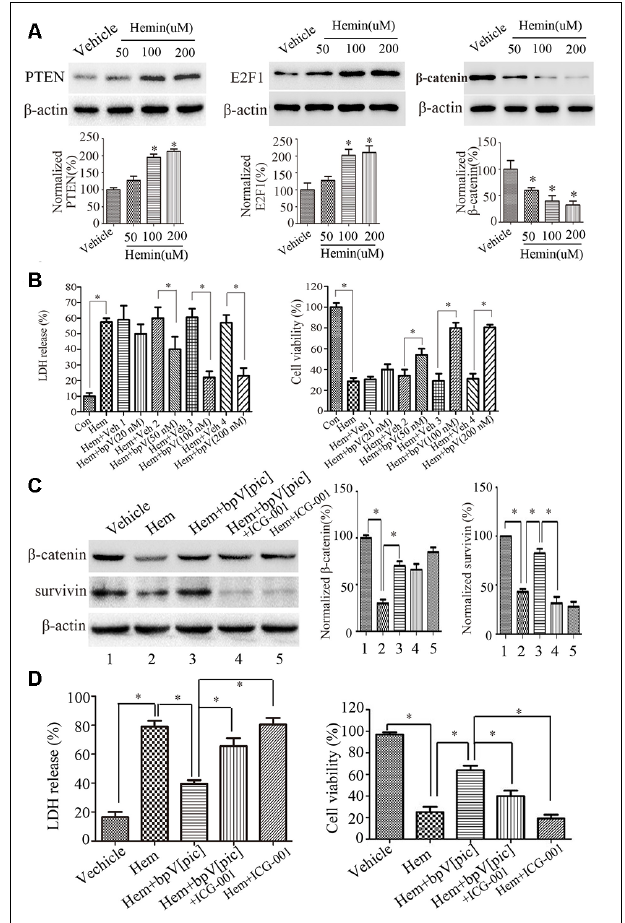
FIGURE 6 | BpV[pic] prevented hemin-induced neuronal damage through the regulation of β -catenin expression and activity via PTEN/E2F1 pathway in vitro . (A) Western blot showed it increased the expression of PTEN and E2F1, decreased the expression of β -catenin concentration-dependently in hemin-treated cultured rat cortical neurons for 24 h ( ∗ p < 0.05 compared to Vehicle, one-way ANOVA test, followed by Bonferroni post hoc test, N = 8). (B) It decreased lactate dehydrogenase (LDH) release and increased cell viability dose-dependently 6 h after bpV[pic] (50–200 nM) administered in hemin-induced rat cortical neuron injuries ( ∗ p < 0.05 , one-way ANOVA test, followed by Bonferroni post hoc test, N = 8). (C) Rat cortical neurons treated with bpV[pic] were administered with or without β -catenin inhibitor ICG-001. Western blot showed that bpV[pic] increased the levels of β -catenin and survivin (a β -catenin activation marker), which were decreased by hemin. Meanwhile, ICG-001 blocked the expression of survivin ( ∗ p < 0.05, one-way ANOVA test, followed by Bonferroni post hoc test, N = 8). (D) LDH and MTT assay showed that the protective effect of bpV[pic] against hemin-induced neurotoxicity was blocked by ICG-001 ( ∗ p < 0.05 , one-way ANOVA test, followed by Bonferroni post hoc test, N = 8; Hem, Hemin; Veh, Vehicle; ICG-001, β -catenin